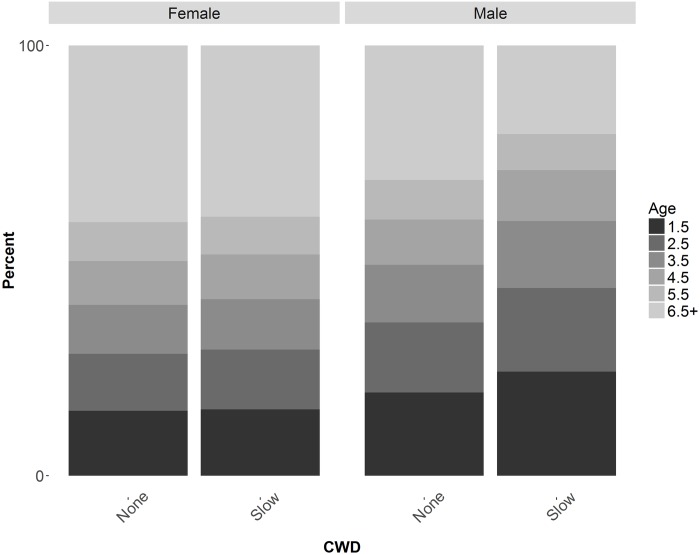
Age structure of male and female population after 25-year simulations with and without CWD.Slow CWD started at 1% prevalence and increased 0.26% annually.